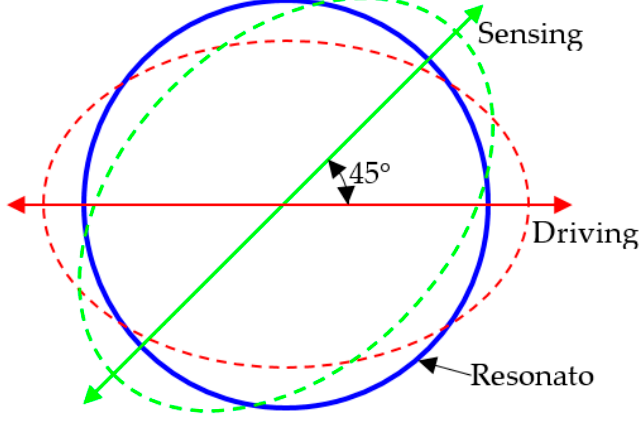
Figure 2. Mode shape of the resonator.